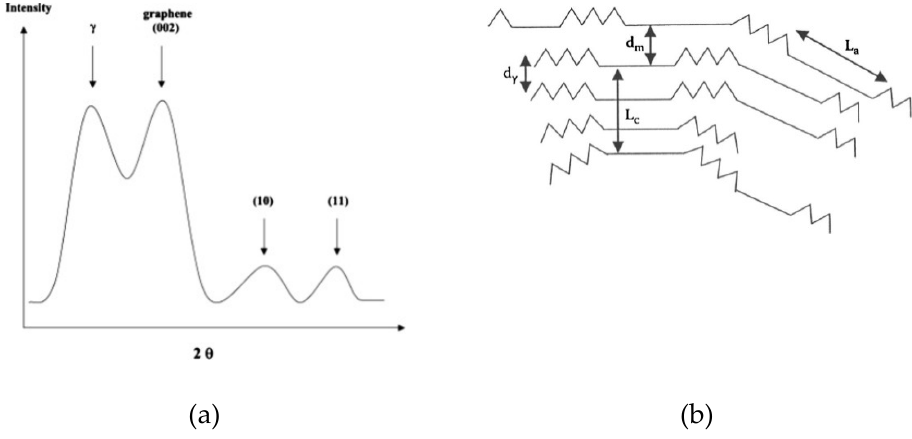
Figure 2. X-ray diffraction pattern of a petroleum asphaltene sample ( a ) [33] and a cross-sectional view of the asphaltene model ( b ) [34]. Reproduced or adapted from [33,34], with permission from Elsevier, 2002 and CRC Press Taylor & Francis Group, 2009.